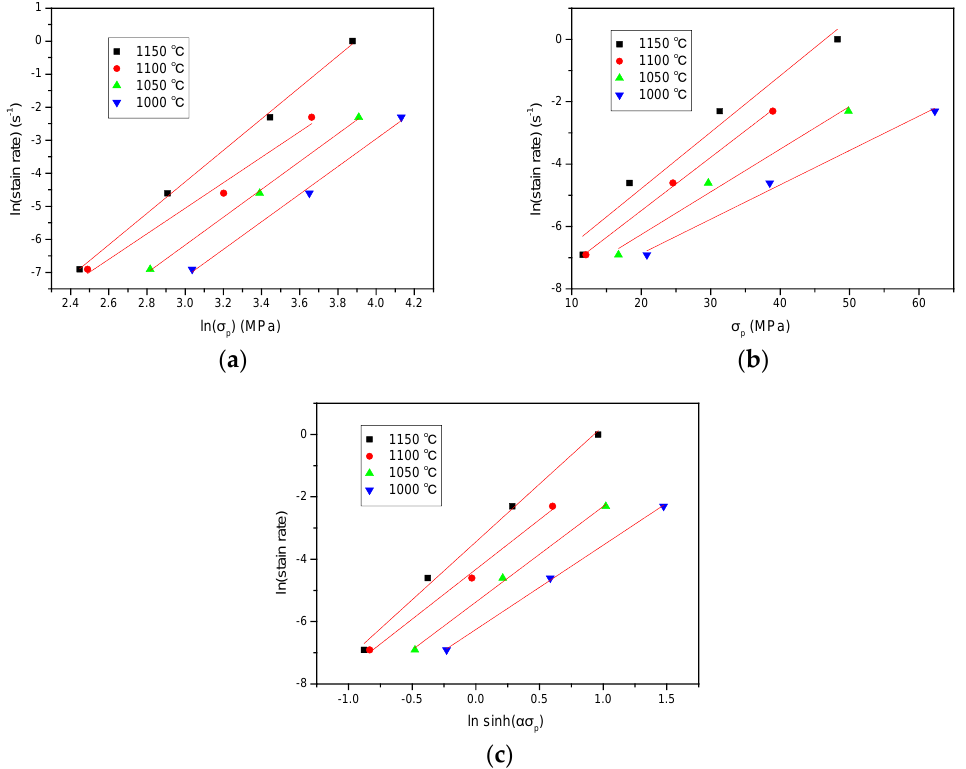
Figure 5. Relationship between peak stress and strain rate of Fe-Cr-Al-La stainless steel: ( a ) relation- ship of ln 𝜀̇ − ln 𝜎 𝑝 ; ( b ) relationship of ln 𝜀̇ − 𝜎 𝑝 ; and ( c ) relationship of ln𝜀̇ − lnsinh(𝛼𝜎 𝑝 ) . According to Equation (2), the apparent activation energy can be determined using Equation (7): 𝜕 ln sinh(𝛼𝜎) 𝑄 = 𝑛R Figure 6 shows the fitted linear relationships of ln sinh(𝛼𝜎 𝑝 ) versus 1/ T at different strain rates. According to the data in Figure 6, under different strain rates, the mean value of all the slopes is 11.39. Q is then calculated as 300.19 kJ/mol using Equation (7).